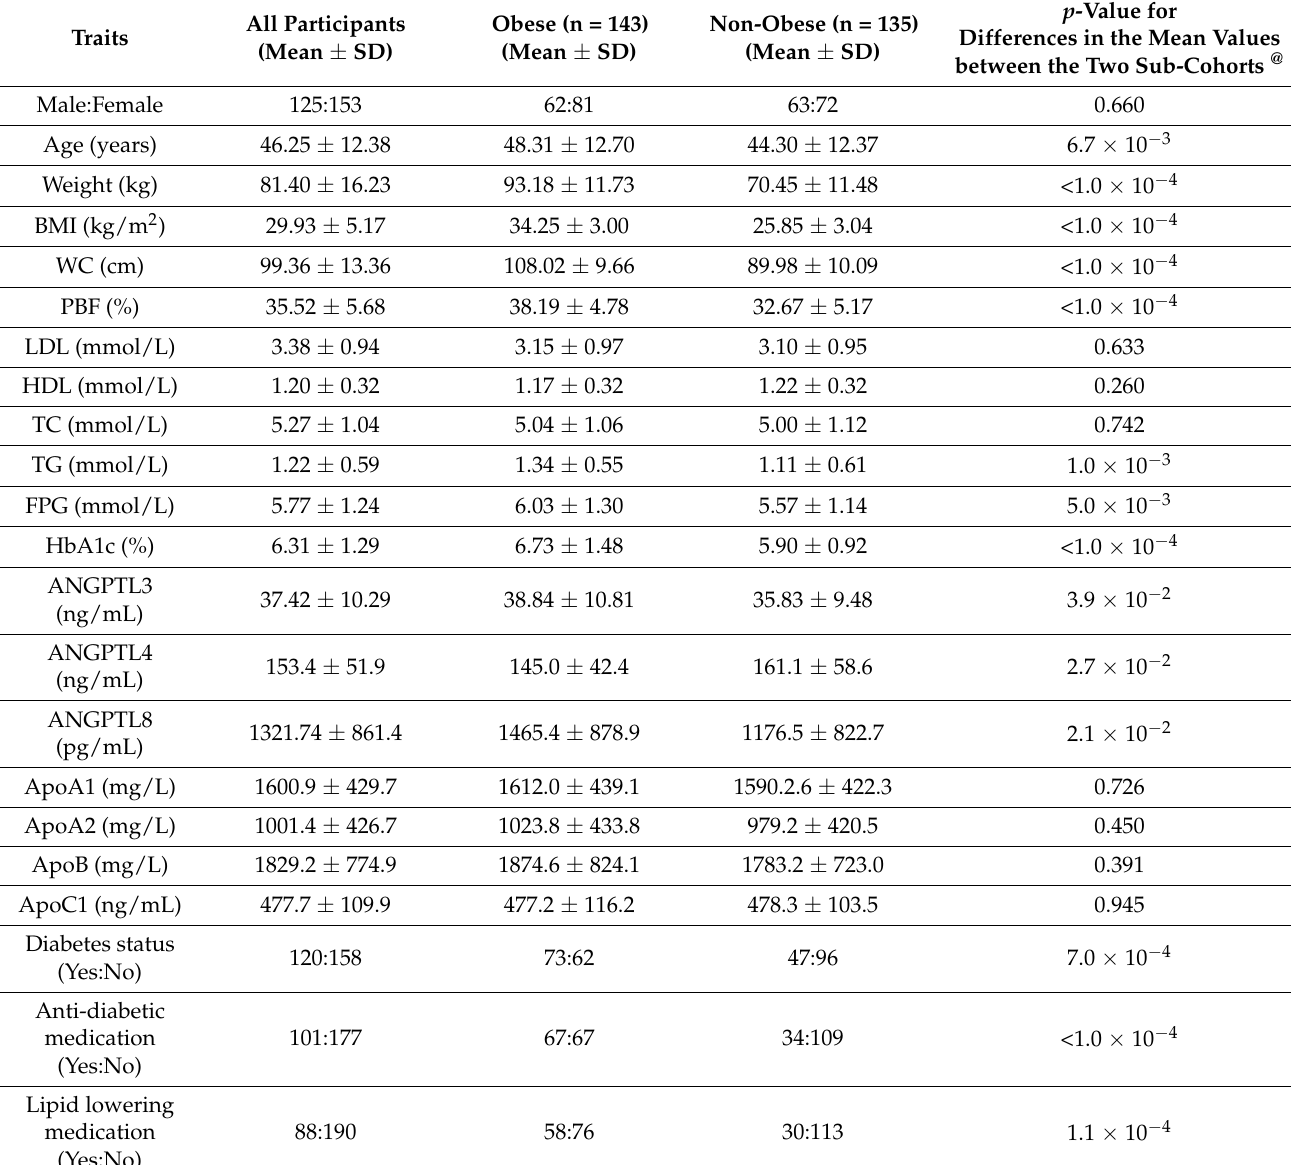
Table 1. Clinical characteristics of the study